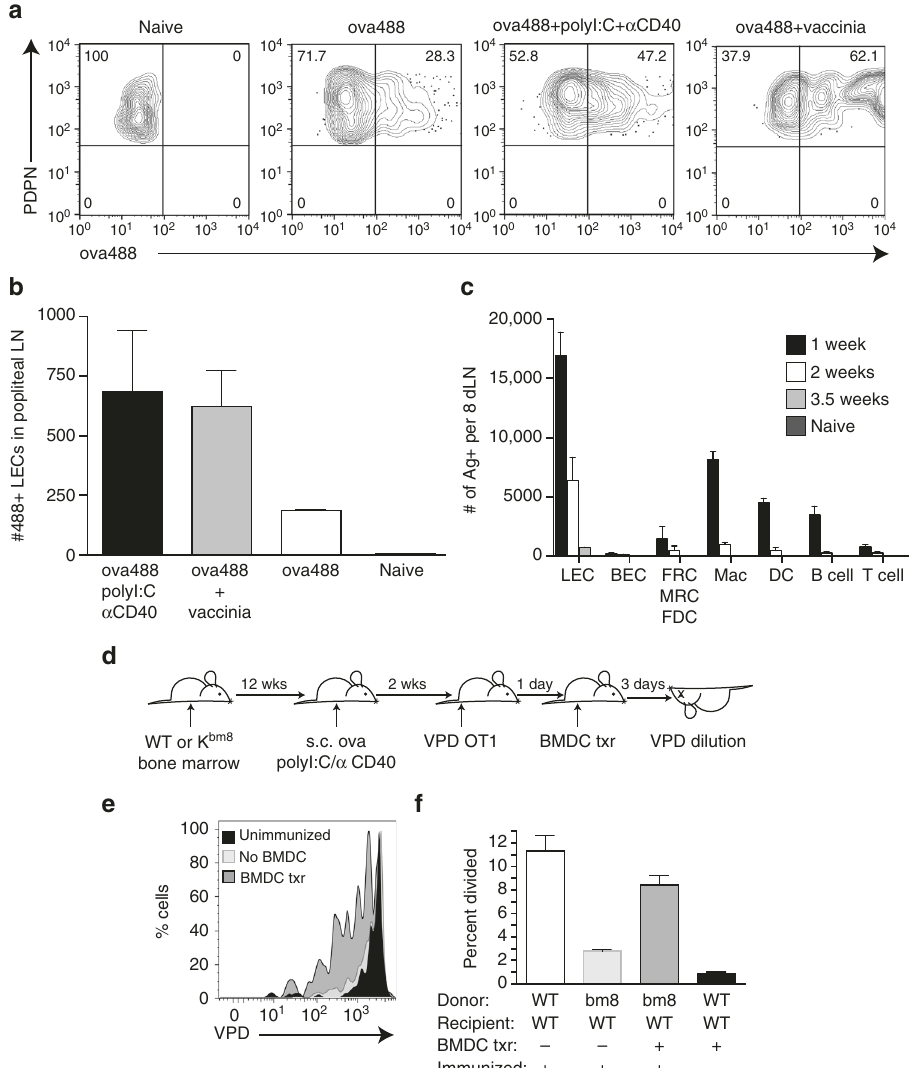
Fig. 1 Archived antigen acquisition and DC antigen presentation. a Representative image of raw data from wild-type mice challenged with antigen (10 μ g/site) alone, antigen with poly(I:C) (2 μ g/site), and anti-CD40 (2 μ g/site) or antigen (10 μ g/site) with vaccinia virus (1 × 10 4 CFU). One week after challenge, mice were harvested and fl ow cytometry was performed to visualize antigen acquisition. Shown are cells gated as in Supplementary Fig. 1B (CD45 − , PDPN + , CD31 + ). b Number of antigen-positive lymphatic endothelial cells per lymph node was calculated from each challenge in a . c Mice were immunized weekly as indicated with antigen and poly(I:C)/aCD40 (as above). LECs were gated as CD45 − , CD31 + , PDPN + , blood endothelial cells (BECs) were gated as CD45 − , CD31 + , PDPN − , FRC/marginal reticular cells (MRC)/FDCs were gated as CD45 − , CD31 − , PDPN + , macrophages (Mac) were gated as (Supplementary Fig. 1). The percent of antigen-positive of each cell type was calculated as a percent of the total cell type. Error bars shown in fi gure are mean ± standard deviation from two independent experiments with three mice per group per time point. d Schematic of the experimental design. e Wild- type mice were irradiated and K bm8 (cannot effectively present the dominant ovalbumin peptide) bone marrow was used to reconstitute the hematopoietic compartment. OT1 T cells were transferred into these mice 2 weeks after immunization with ovalbumin (10 μ g/site), poly(I:C)/anti-CD40 (2 μ g/site),